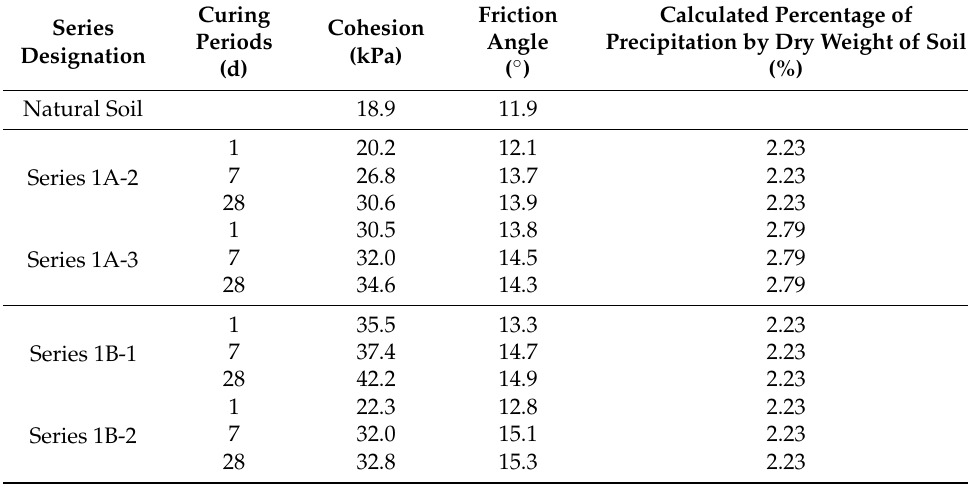
Table 8. The results of direct shear